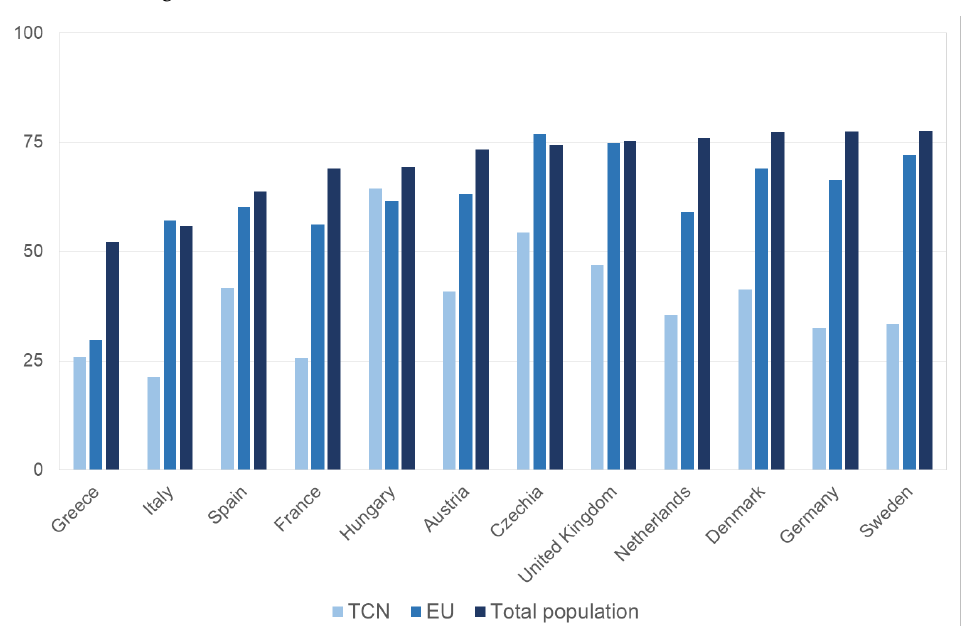
Figure 2 : Female employment rate by country, total female population and first- generation migrants, distinguished by third-country nationals (TCNs) and EU migrants,